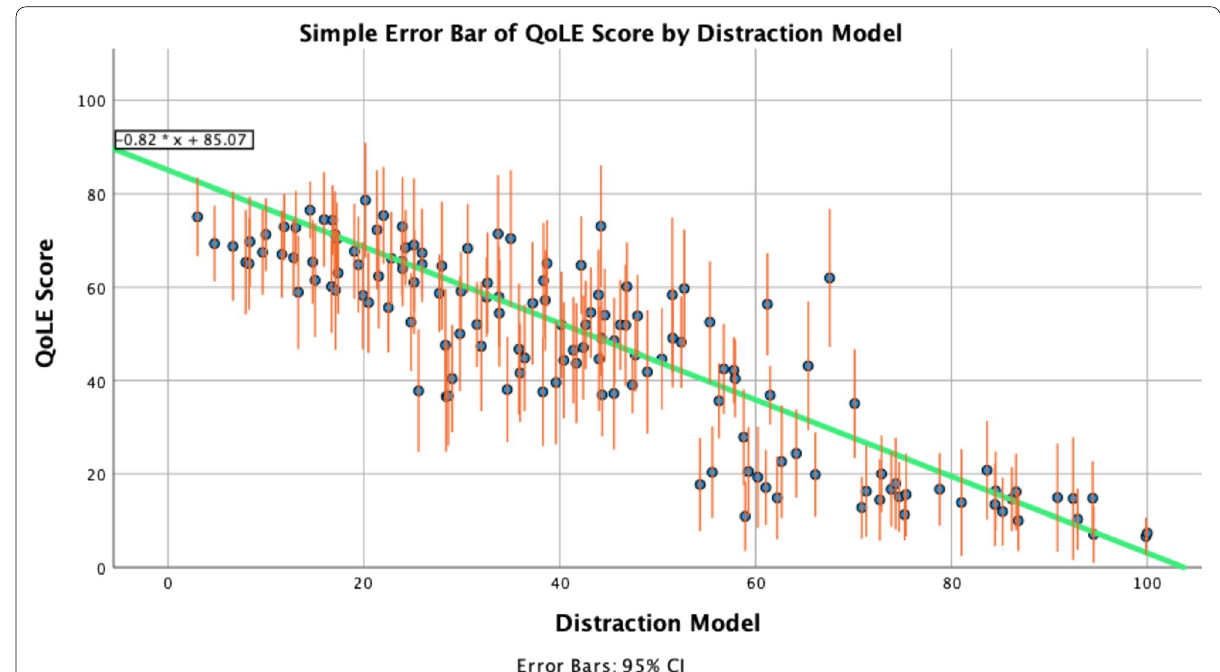
Fig. 6 Error Bar of the QoLE Score with the distraction model. The fit line is also visible, indicating that there is a negative, but linear correlation between the QoLE ratings and distraction